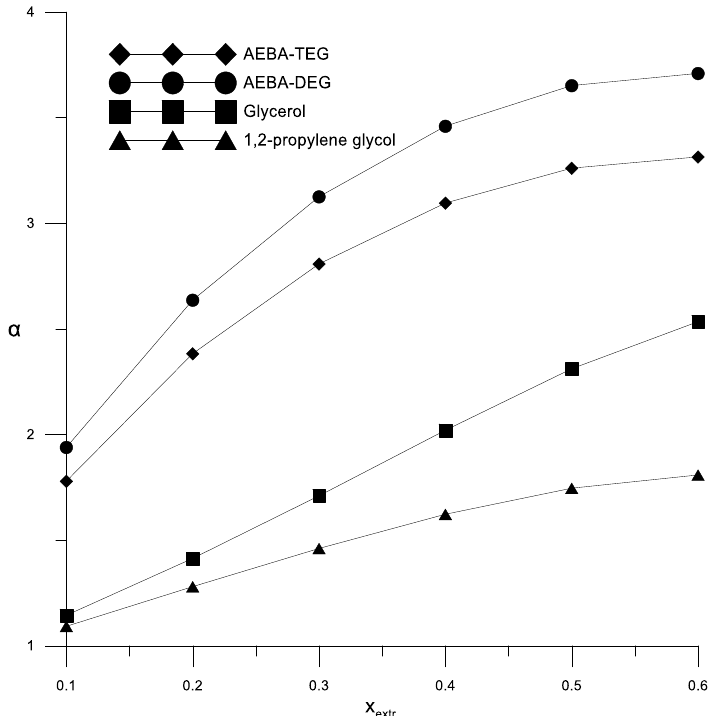
Figure 8. The coefficient of relative volatility depending on the concentration of the extractant at the azeotropic point of the ethanol–water mixture.